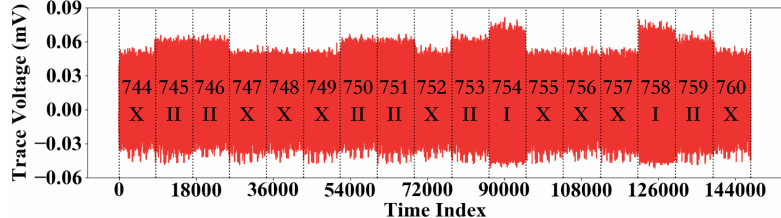
Figure 14: The CISPA on the Optimized NTRU